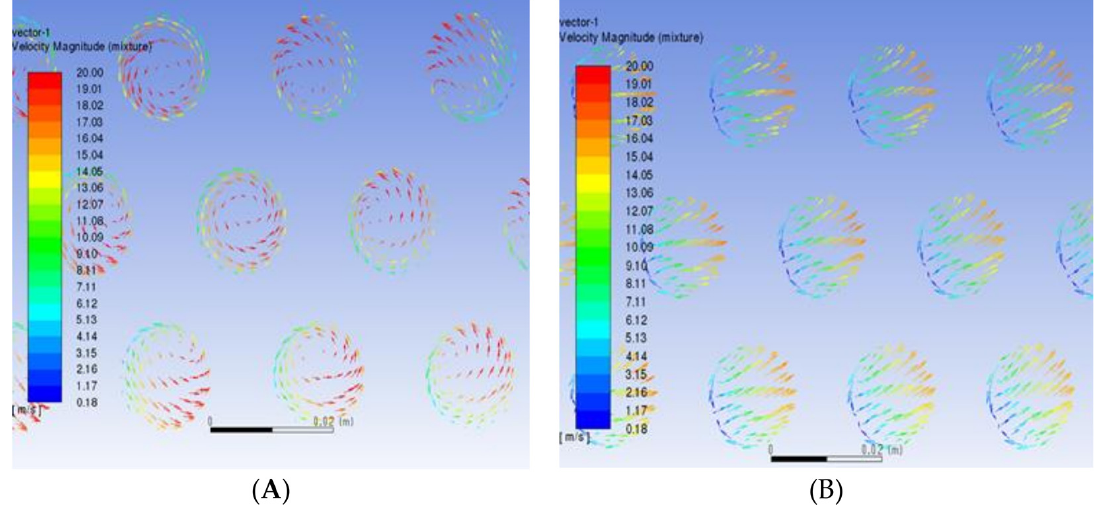
Figure 12. Local velocity vector diagram of tube bundle inlet: ( A ) the vortex core region and ( B ) the peripheral